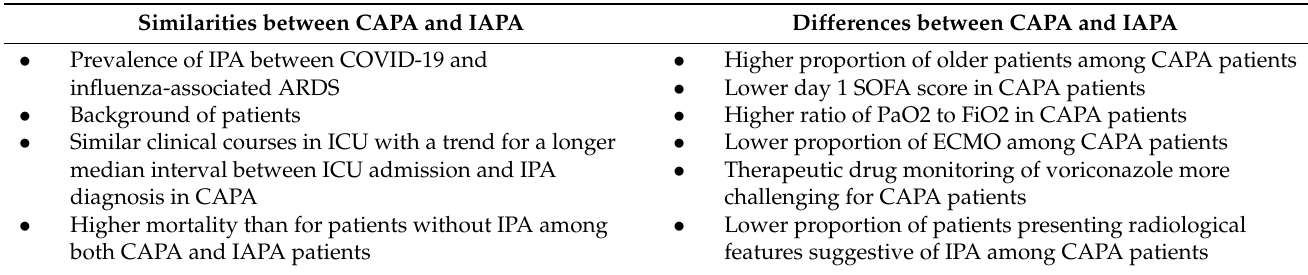
Table 4. Summary of similarities and differences between CAPA and